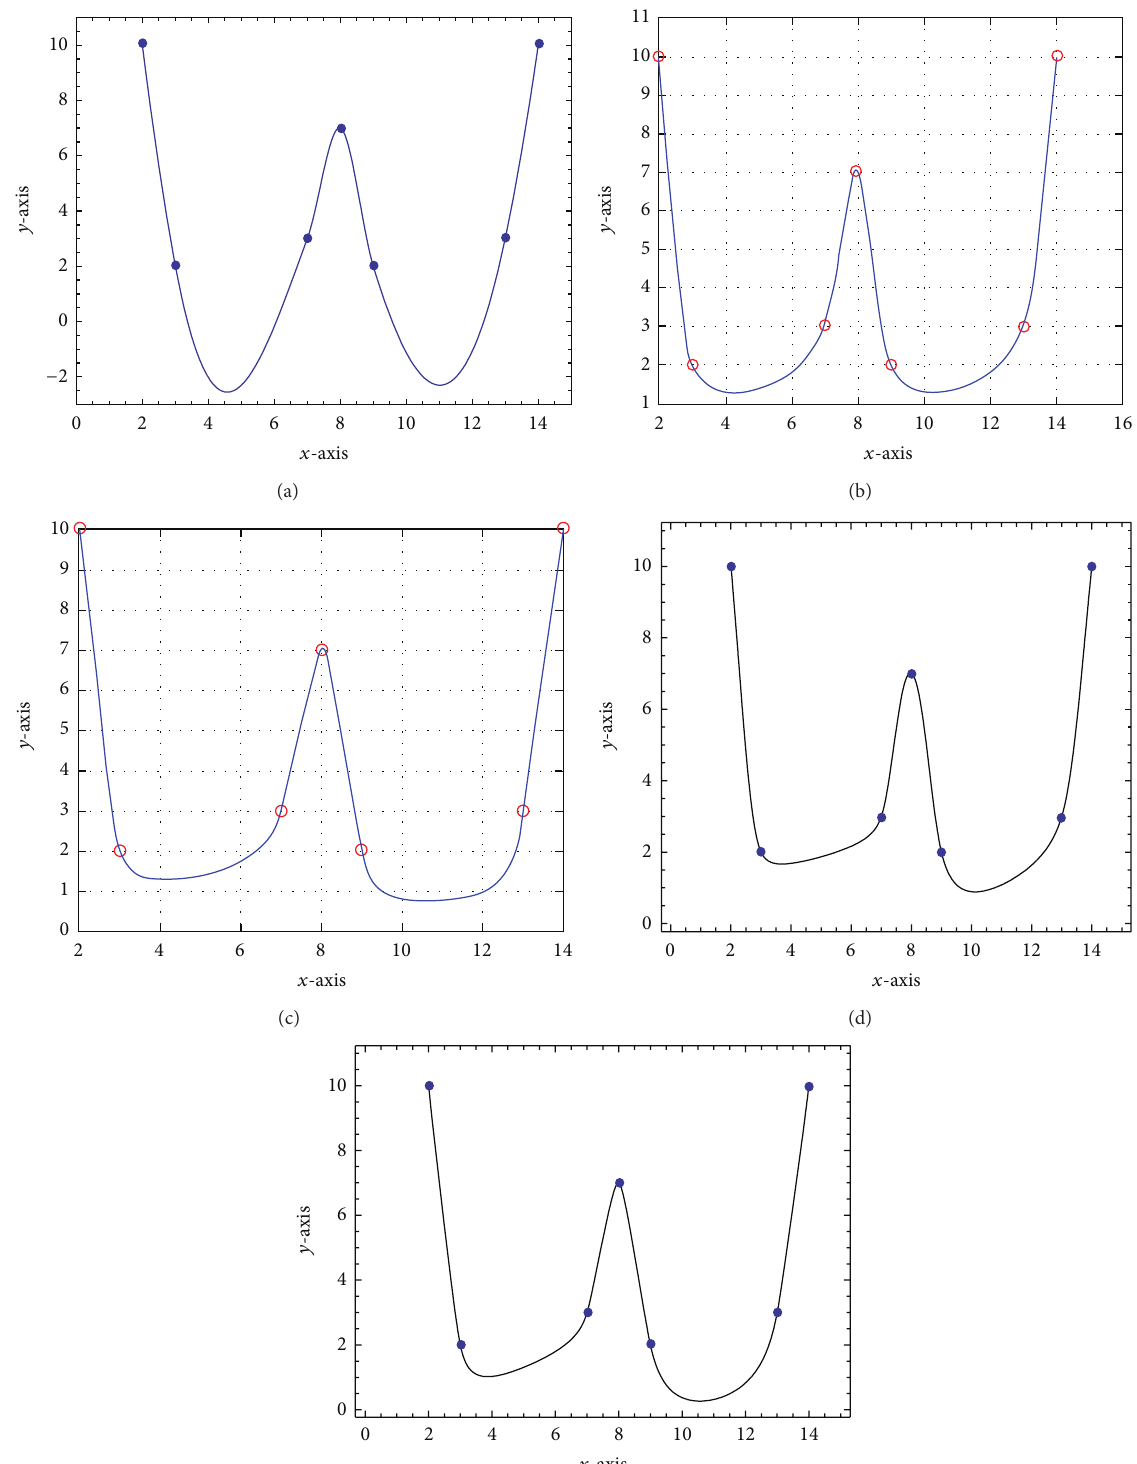
Figure 4: Comparison of (a) cubic Hermite spline curve, (b) Sarfraz et al. [11], (c) Abbas et al. [12], and positivity-preserving rational cubic spline with values of shape parameters: (d) 𝛼 𝑖 = 𝛽 𝑖 = 0.5 ; (e) 𝛼 𝑖 = 𝛽 𝑖 = 2.5